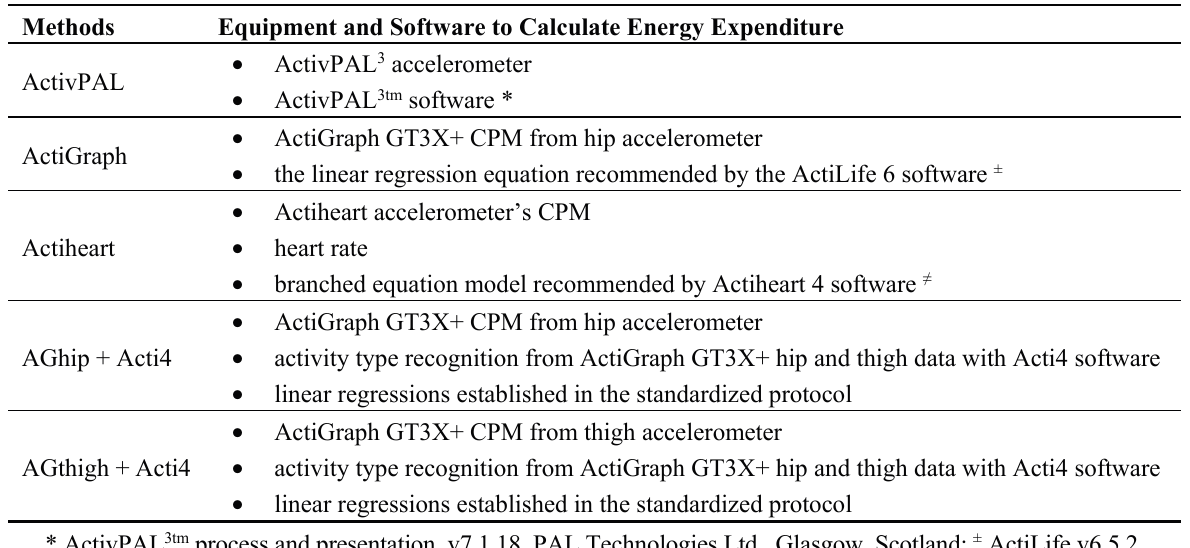
Table 1. Methods based on mounted equipment to calculate energy expenditure of different activities.